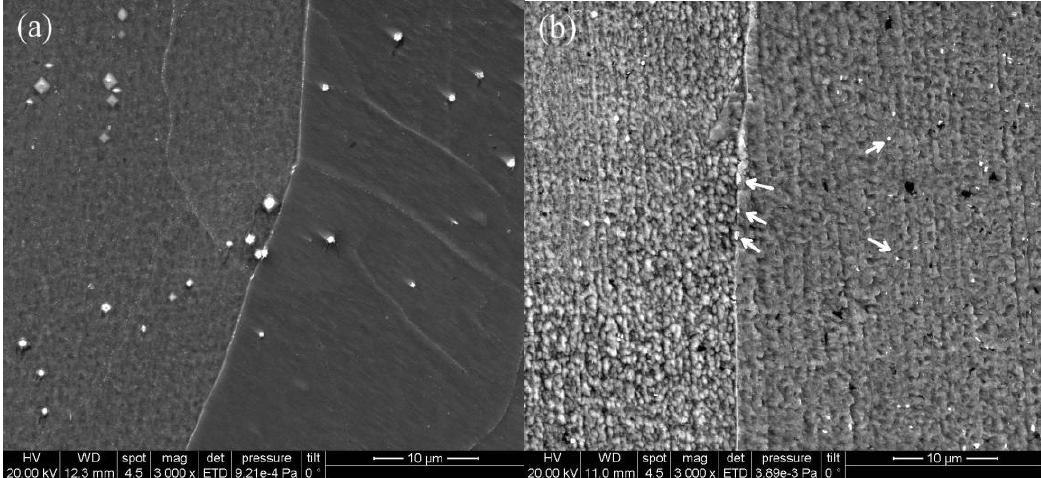
Figure 5. Metallographic structures of the weld cross-sections of ( a ) 441 and ( b ) 441Ce type steel.